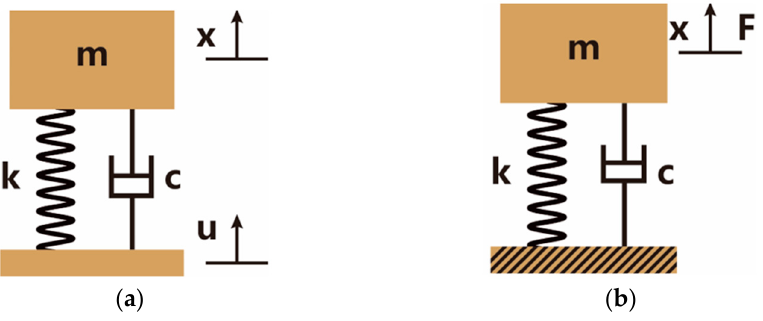
Figure 4. The equivalent model of the OSSS: ( a ) the acceleration transmissibility model; ( b ) the acceleration response model. The parameters 𝑘 and 𝑐 are the equivalent stiffness and damping coefficient along the exciting direction, 𝑚 is the mass of the FOVH, 𝑥 is the displacement of the FOVH, 𝑢 is the displacement of the outer frame in the acceleration transmissibility model, and 𝐹 is the ambient exciting force provided by the signal in the acceleration response model.